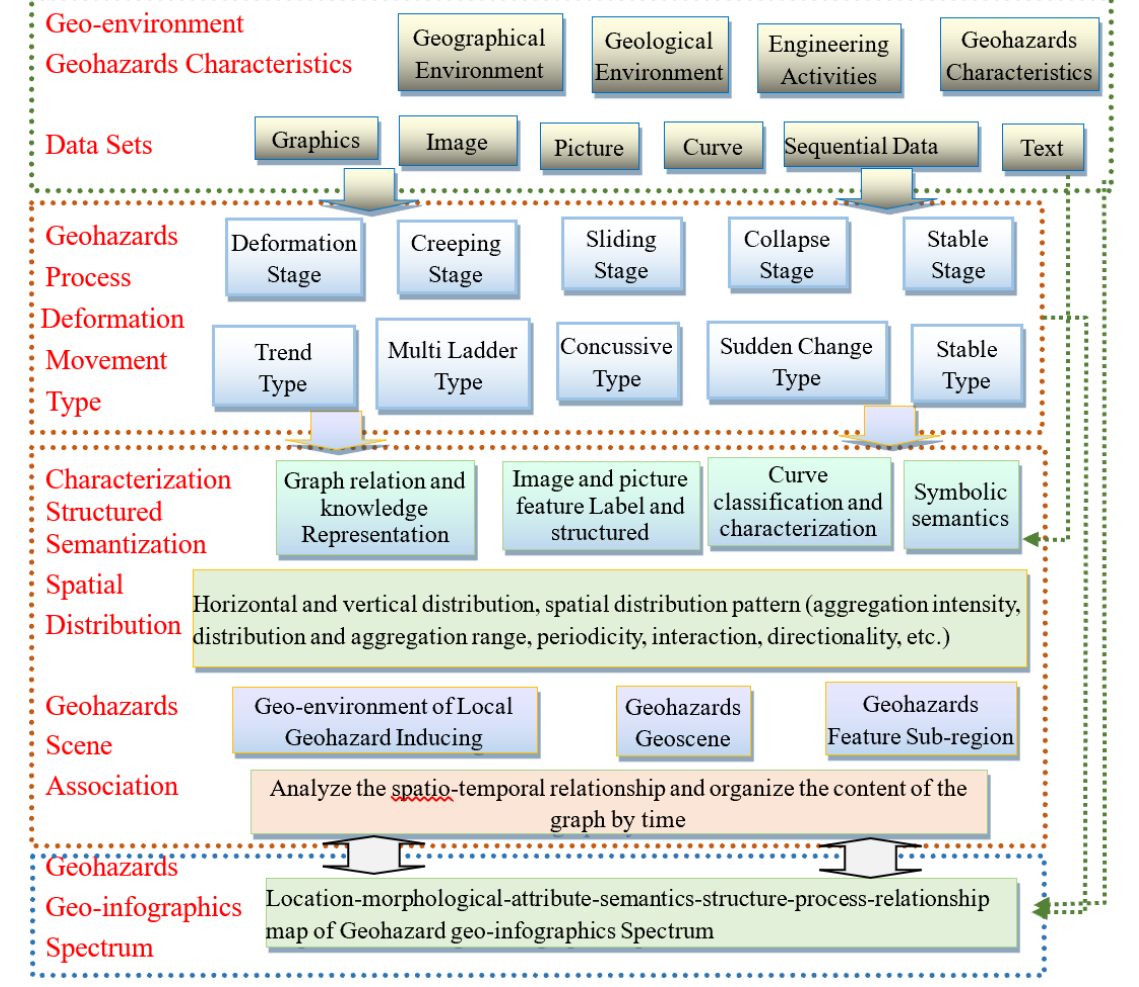
Fig. 3 Characteristics of surface geohazards-disaster process-spatial distribution-geoscience information